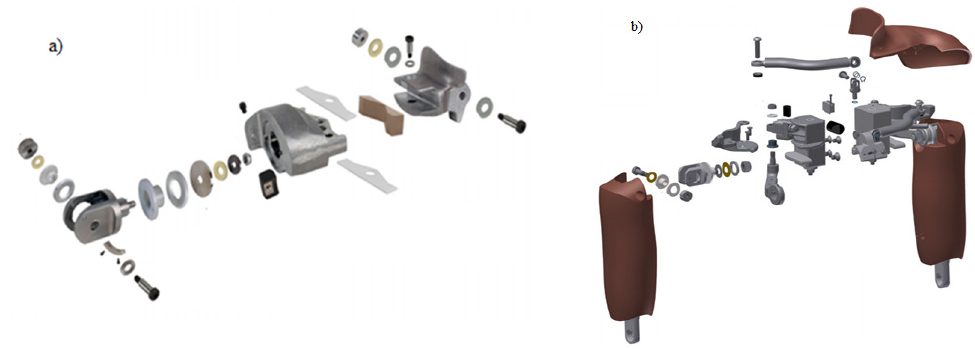
Figure 4. Shoulder joint used on a 50 percentile male dummy: ( a ) Hybrid III, ( b ) THOR [25].